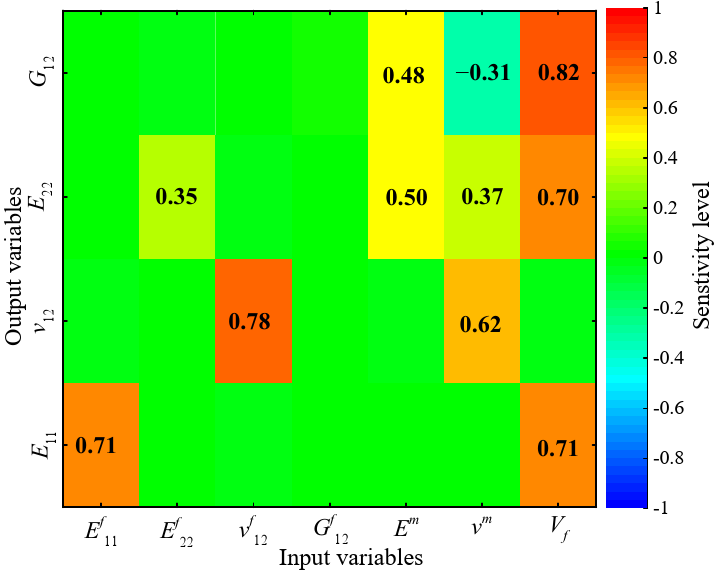
Figure 10. Correlation coefficients between the elastic properties and the constituent’s properties of the T800/X850 composite.